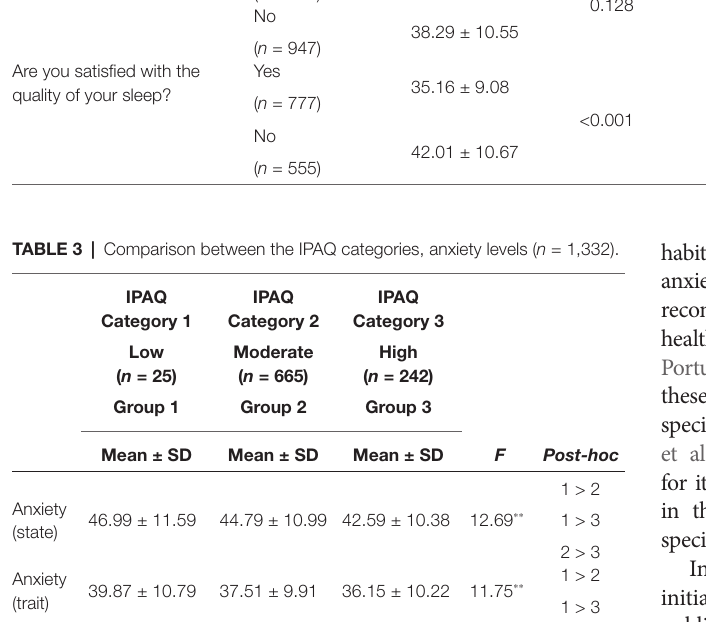
Are you satisfied with the quality of your sleep?